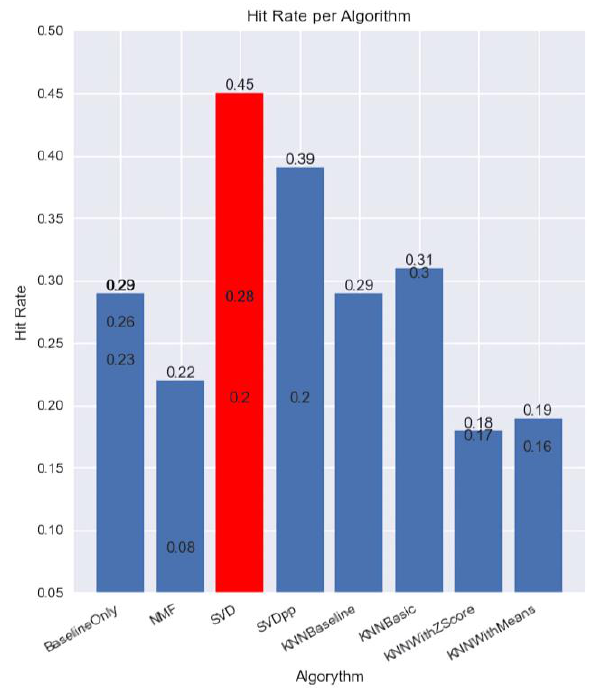
Figure 9. Surprise library HR per algorithm